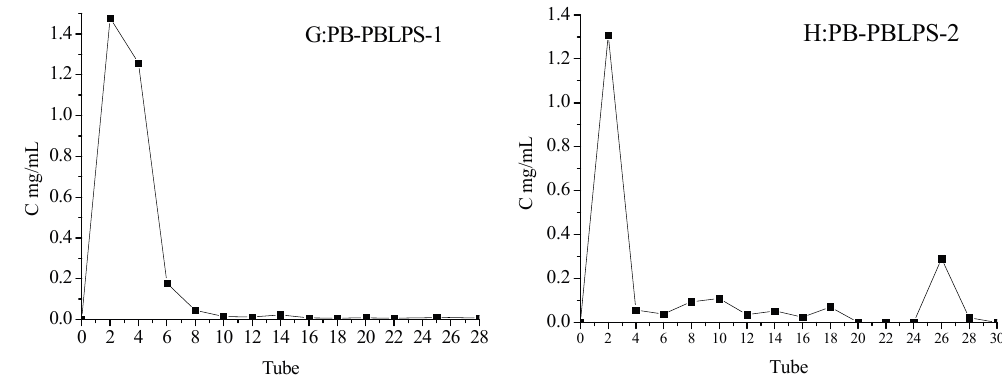
Figure 4. Enrichment and separation of BLPS by Sephadex G-100 from the four kind viarieties of bamboo leave: PBLPS: Purified BLPS. ( A , B ) from Phyllostachys nigra (PN); ( C , D ) from Phyllostachys vivax (PV); ( E , F ) from Chimonobambusa quadrangularis (Fenzi) Makino (CQ); ( G , H ) from Phyllostachys bambusoides